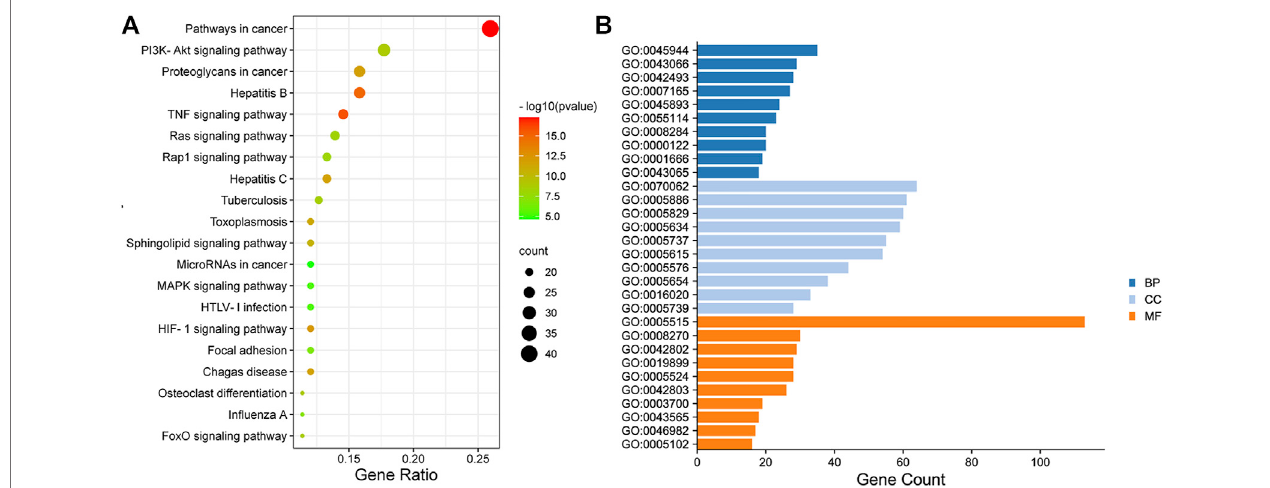
FIGURE 4 | The Dotplot for KEGG pathway (A) and GO enrichment analysis of the predicted targets in Biological Process, Molecular Function, and Cell Composition (B) .In Figure4A ,thesizeofeachnoderepresentsplentifulcounts.Colorindicatesplentiful p -value.In Figure4B ,BPrepresentsBiologicalProcesses,CC represents Cellular Components, MF represents Molecular